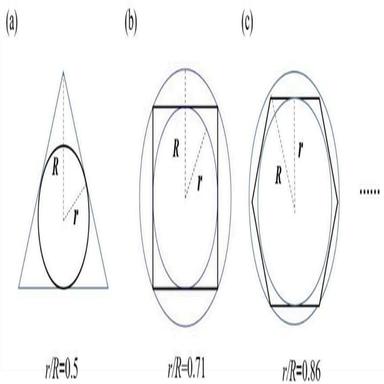
A schematical diagram of the roundness of micro-voids: (a) triangle micro-voids, (b) quadrangle micro-void and (c) hexagon micro-void.